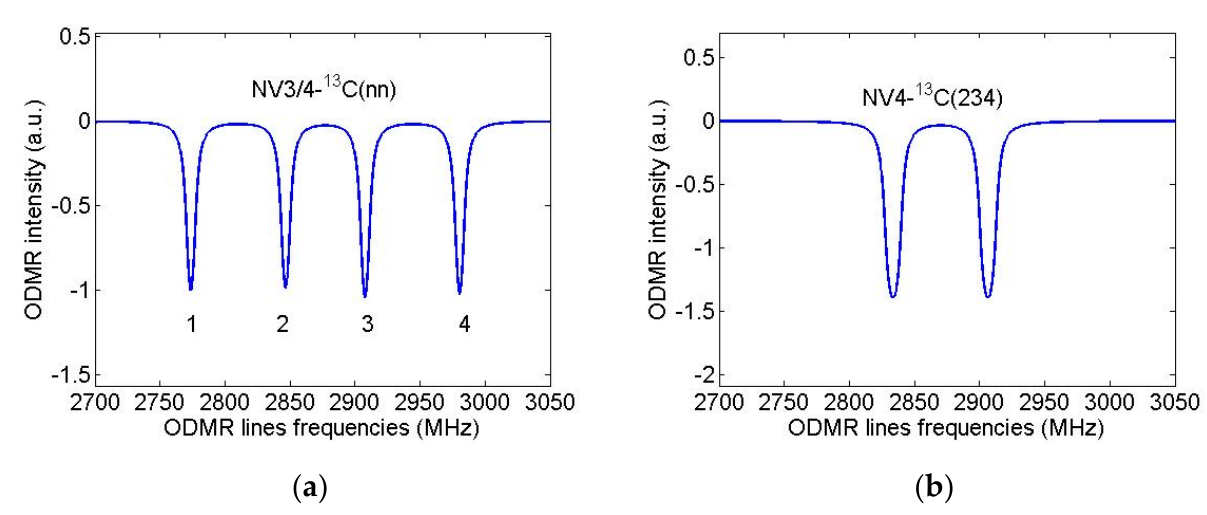
Figure 7. Simulated ODMR spectra of a single NV-C spin systems in nanodiamond grown from 2-azaadamantane with the subsequent formation of the vacancy V3 or V4. Magnetic field B = 13 G was assumed to be aligned along NV axis, ODMR linewidths (HWHM) were taken to be 3 MHz. ( a ) NV3-C(nn) spin system ( ∆ 0 ~ 134 MHz), ( b ) NV4-C(234) spin system ( ∆ 0 ~ 6.4 MHz).